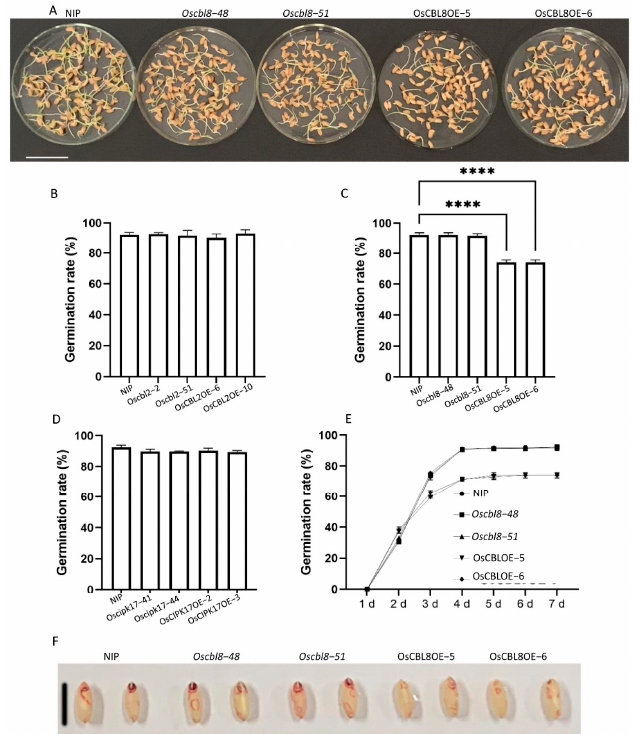
Figure 2. OsCBL8 can negatively regulate rice seed germination rather than OsCBL2 and OsCIPK17. ( A ) Germination phenotype of OsCBL8 knockout and overexpression lines on seed germination of rice. Each petri dish contained 100 rice seeds. Photographs of 7-day-old plants are shown. Bar = 4 cm. ( B ) Seed germination rate of OsCBL2 knockout and overexpression lines. ( C ) Seed germination rate of OsCBL8 knockout and overexpression lines. ( D ) Seed germination rate of OsCIPK17 knockout and overexpression lines. ( E ) Changes in seed germination rate of knockout and overexpression lines of OsCBL8 in 7 days. Data of ( B – E ) are mean ± SD. from three biological replicates. Statistical analysis was performed using Š í d á k’s multiple comparisons test and Dunnett’s multiple comparisons test; **** p < 0.0001. ( F ) The vigor of seeds was demonstrated by TTC (2, 3, 5-triphenyltetrazole chloride) staining. After the seeds were immersed in TTC staining, they were cultured at 33 ◦ C for 2 h and photographed for observation. The redder the seed color, the higher the seed vigor. Bar = 6